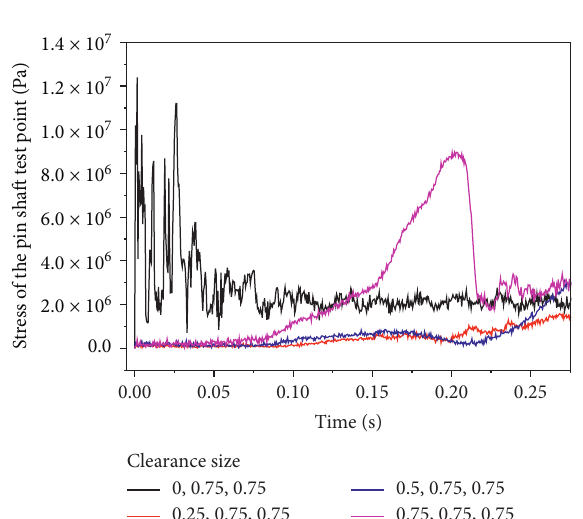
Figure 10: Acceleration of the tail beam test point.